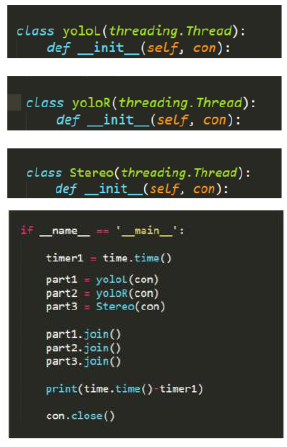
Figure 9. Cropped YOLOv3 Result (Right Image)